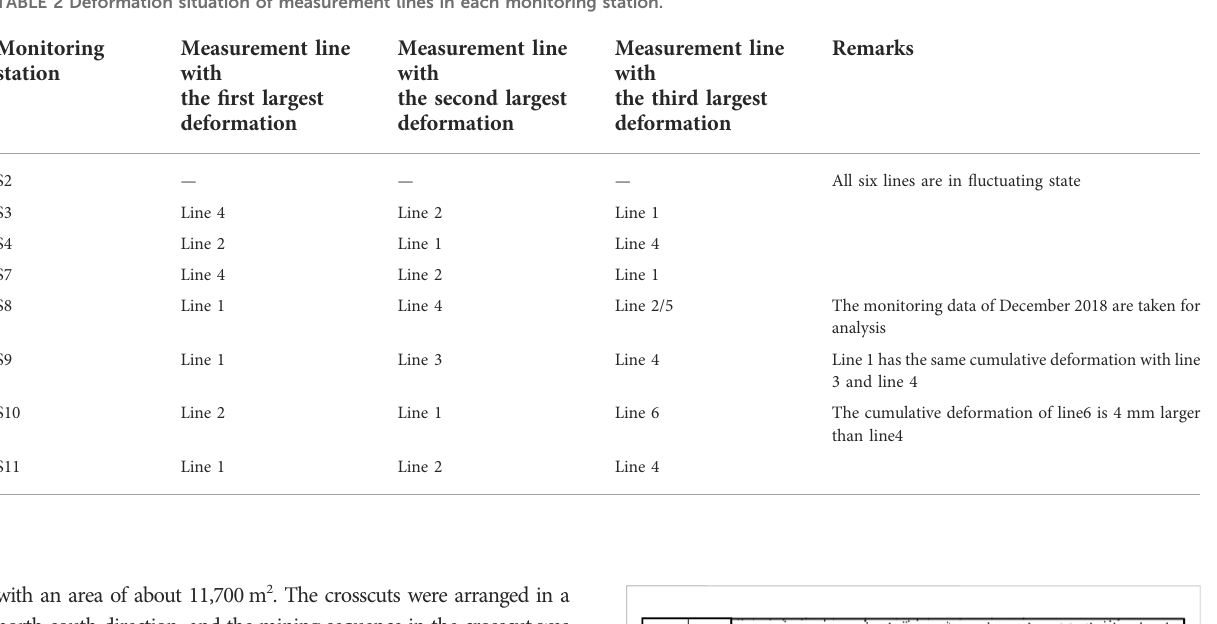
TABLE 2 Deformation situation of measurement lines in each monitoring station.